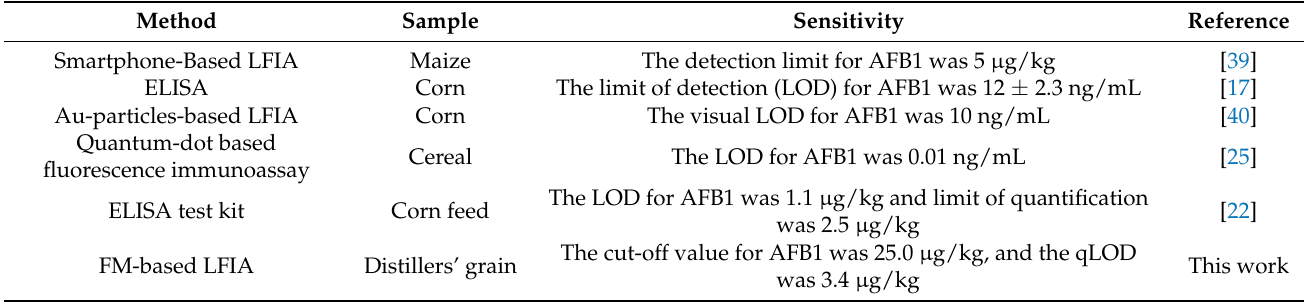
Table 5. Comparison of different immunoassays for AFB1 determination in